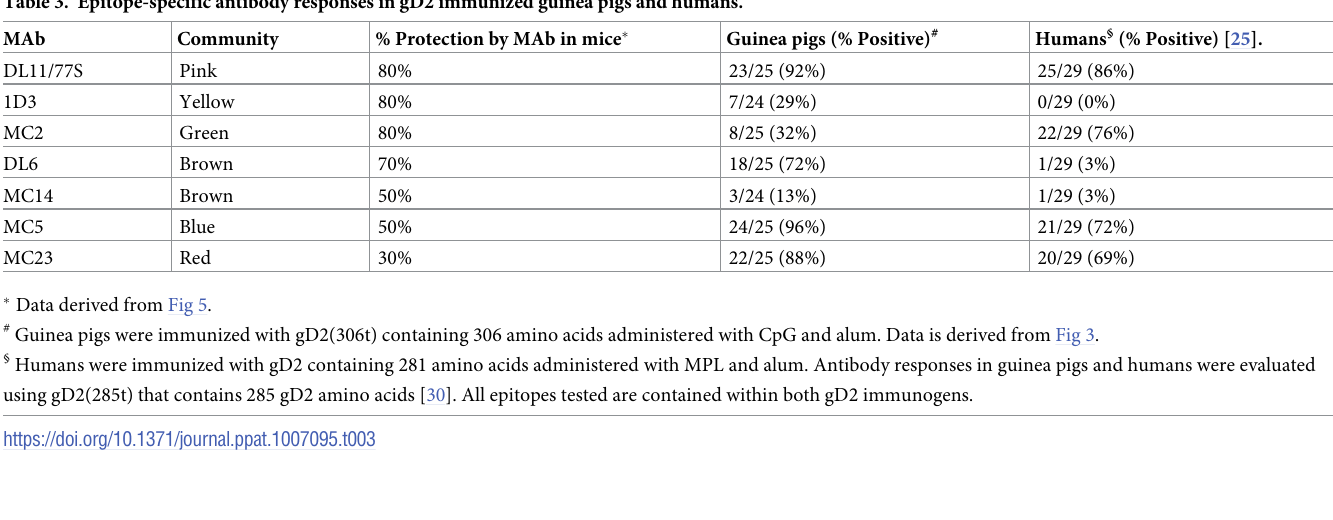
Table 3. Epitope-specific antibody responses in gD2 immunized guinea pigs and humans. MAb